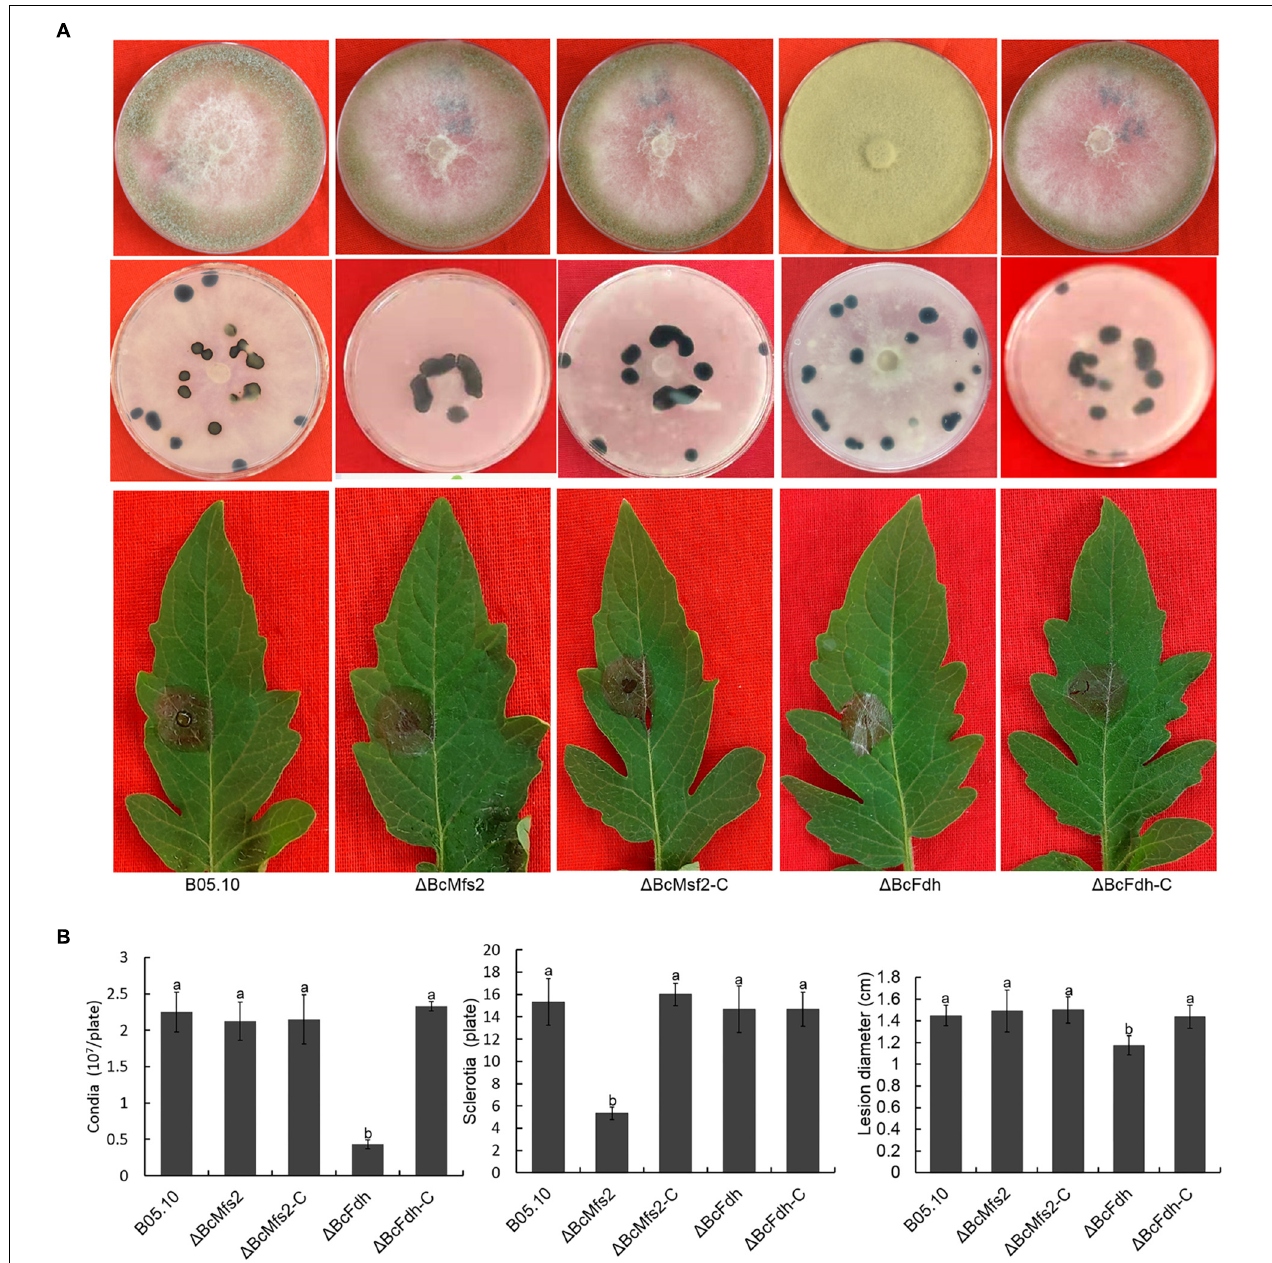
FIGURE 8 | Impact of BcMFS2 and BcFDH deletion on pathogenicity of B. cinerea . (A) Effect of deletions BcMFS2 or BcFDH on conidia biosynthesis, sclerotia formation and virulence. (B) Quantification of conidia, sclerotia and pathogenicity of different strains. Bars represent standard errors from three experiments. In each biological experiment, lesion diameters of nine leaves were investigated. Three plates were used to count sclerotia and conidia. Statistical tests were carried out using Tukey’s test. The different letters marked on the columns indicate statistical significance p <